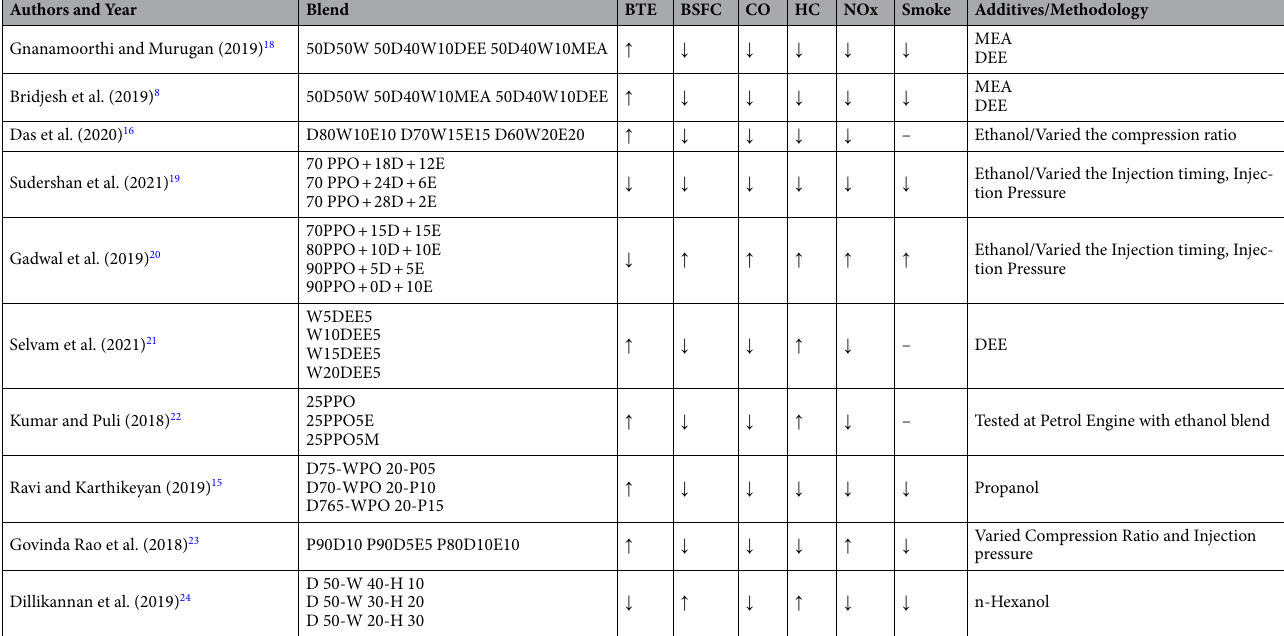
Table 1. Waste plastic fuel blends and their performance with oxygenated additives. BSFC brake specific fuel consumption, BTE brake thermal efficiency, CO carbon monoxide, DEE diethyl ether, E ethanol, EEA ethoxy ethyl acetate, H n-Hexanol, HC hydrocarbons, M methanol, MEA methoxy ethyl acetate, NO x nitrogen oxides, P plastic oil, ppm parts per million, PPO plastic pyrolysis oil, W , WPO waste plastic oil. ↑ : Increased; ↓ :